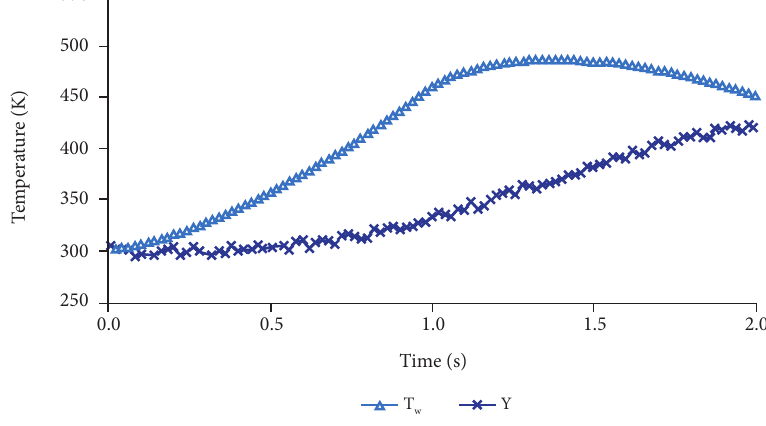
Figure 3. Temperature in the outer and inner wall in the study